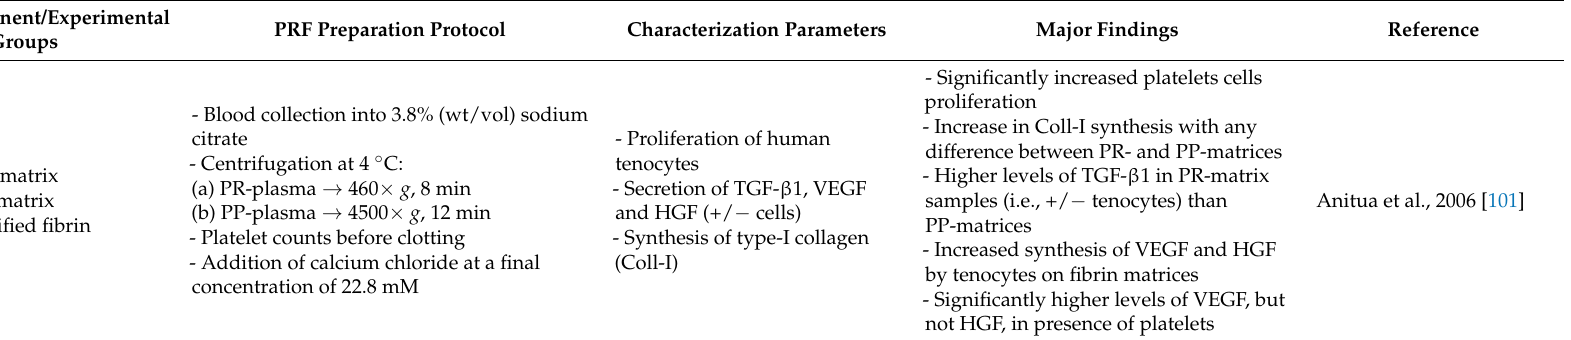
Table 4. In vitro studies on PRF and